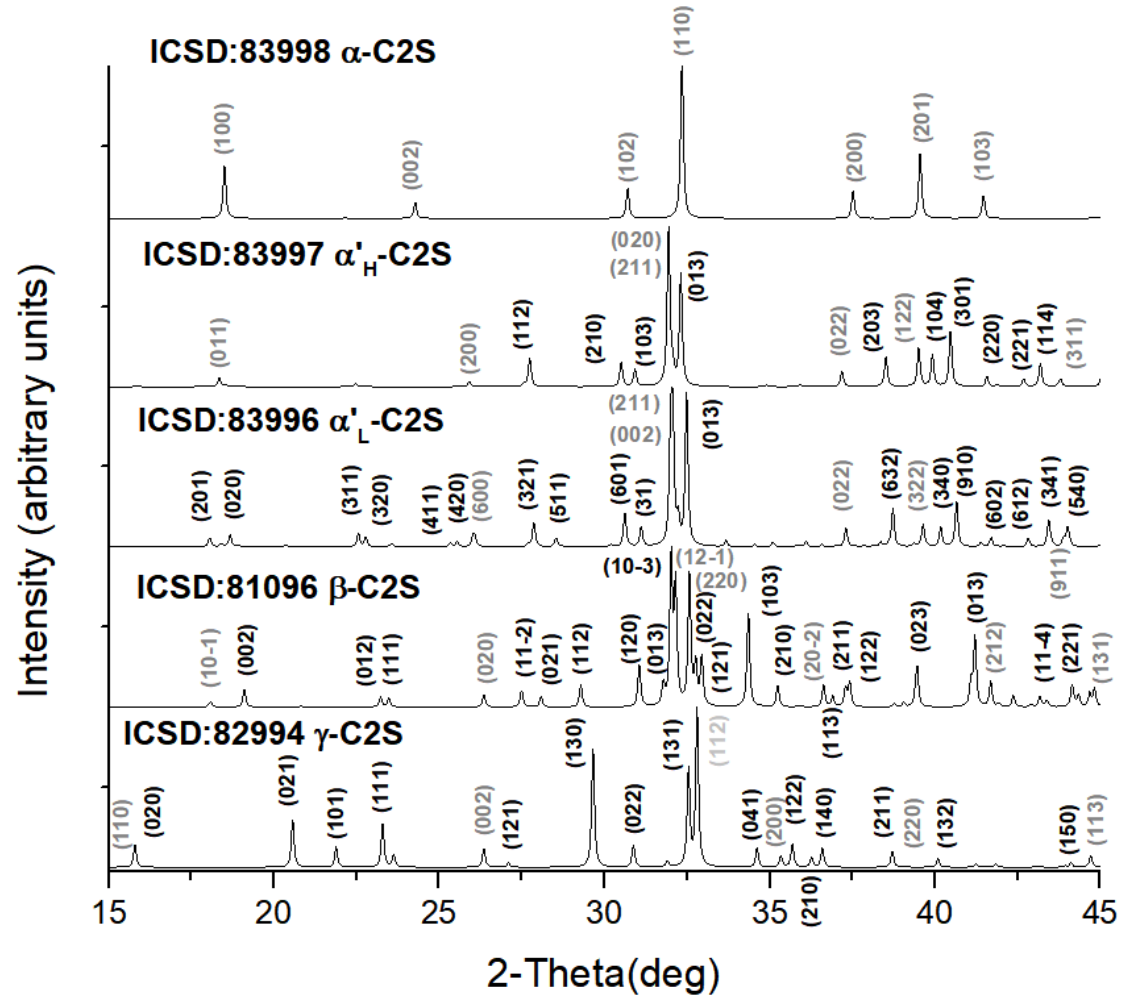
Figure 9. Simulated powder diffraction patterns for all the belite polymorphs (Cuk α radiation) based on the ICSD data of the corresponding code numbers (Tables 1 and S2).